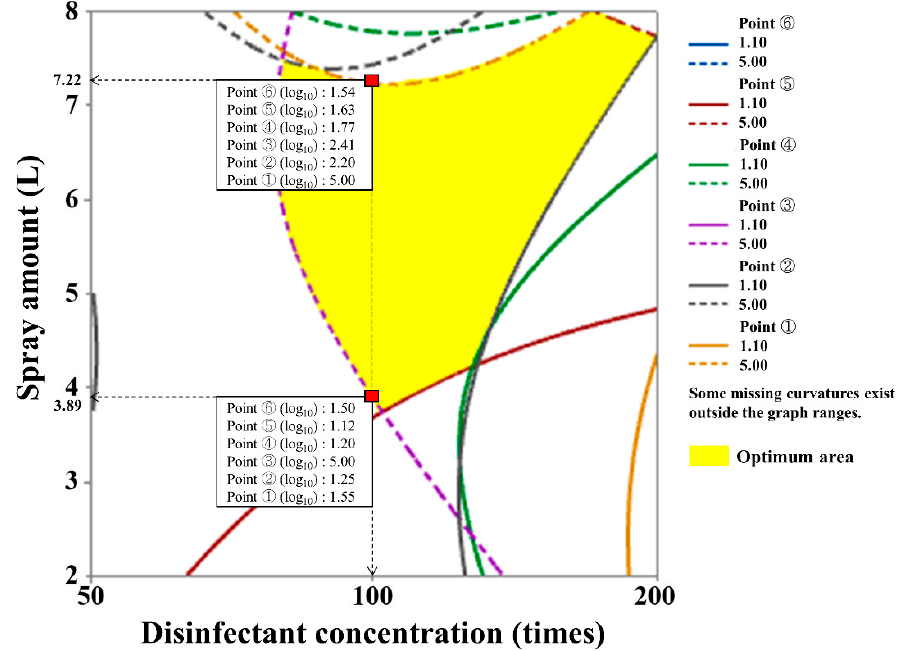
Figure 8. Overlay plot of the disinfectant concentration and spray amount on the disinfection efficiency at each point when the room size is 230 m 3